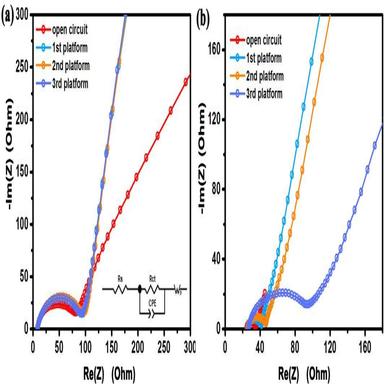
(a) Rate performance of LTO||LVP battery, (b) corresponding Ragone plots. (c) Cycle performance of LTO||LVP battery at 5C rate.